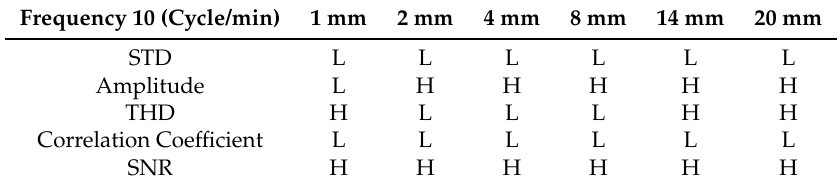
Table A7. Values higher and lower than the median Frequency 10 cycles/min for a 3 mm band.